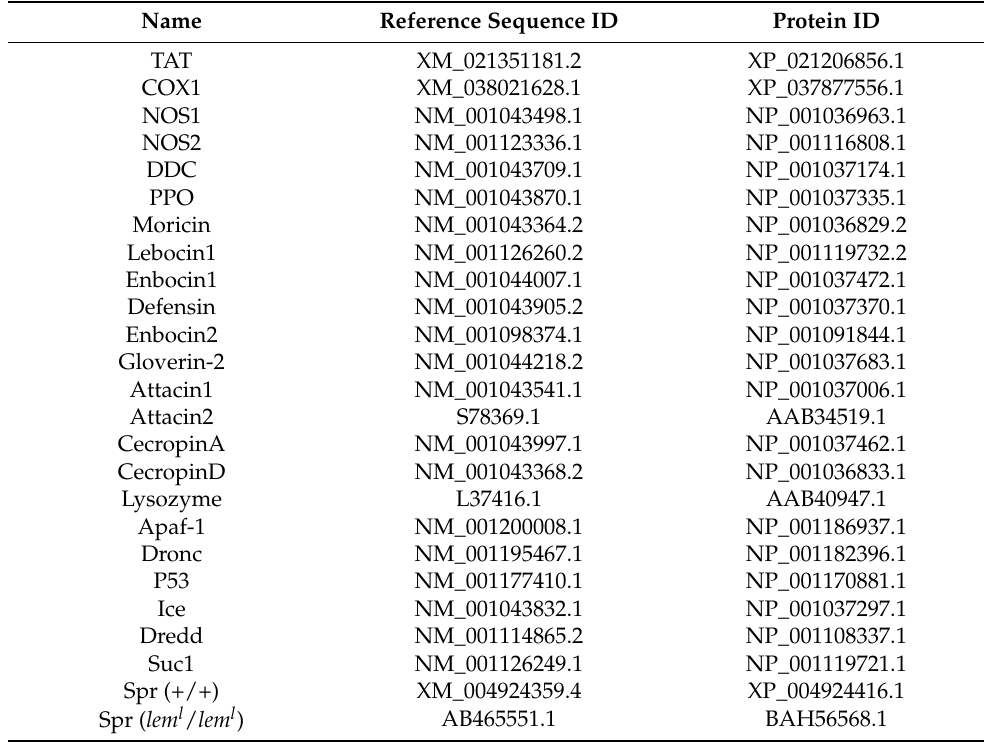
Table 1. Information about the genes covered in this